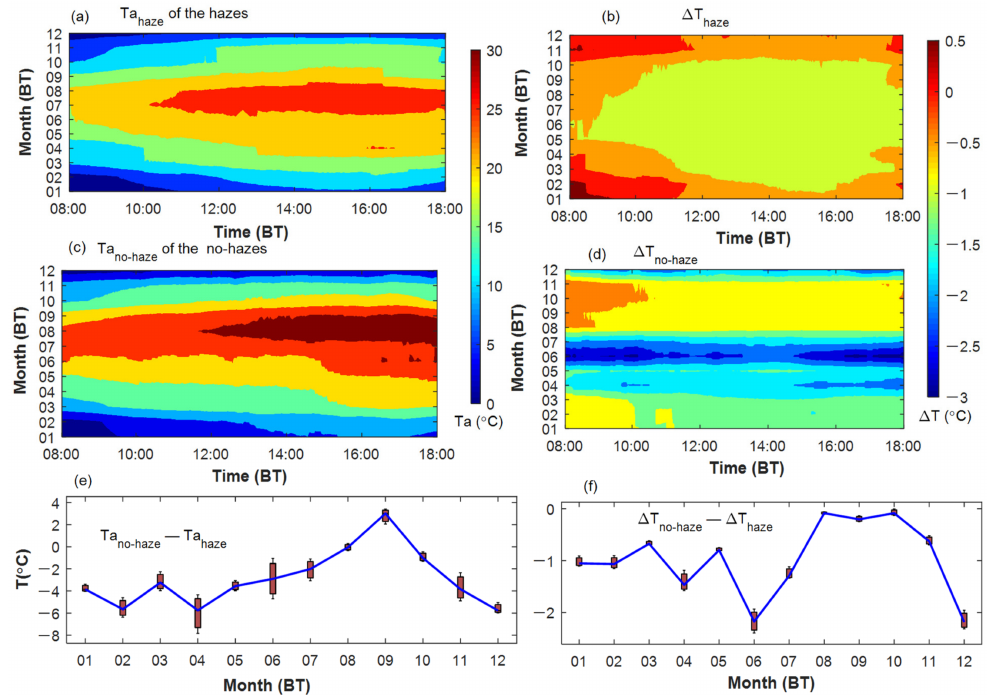
Figure 6. Temporal distribution of average temperature within the BL during ( a ) the haze events Ta haze , ( c ) the no-haze events Ta no − haze ; the distribution of monthly average sensible heat fluxwithin the BL during ( b ) the haze events ∆ T haze ; ( d ) the no-haze events ∆ T no − haze in different months; ( e ) the difference of the Ta no − haze and Ta haze ; ( f ) the difference of the ∆ T no − haze and ∆ T haze